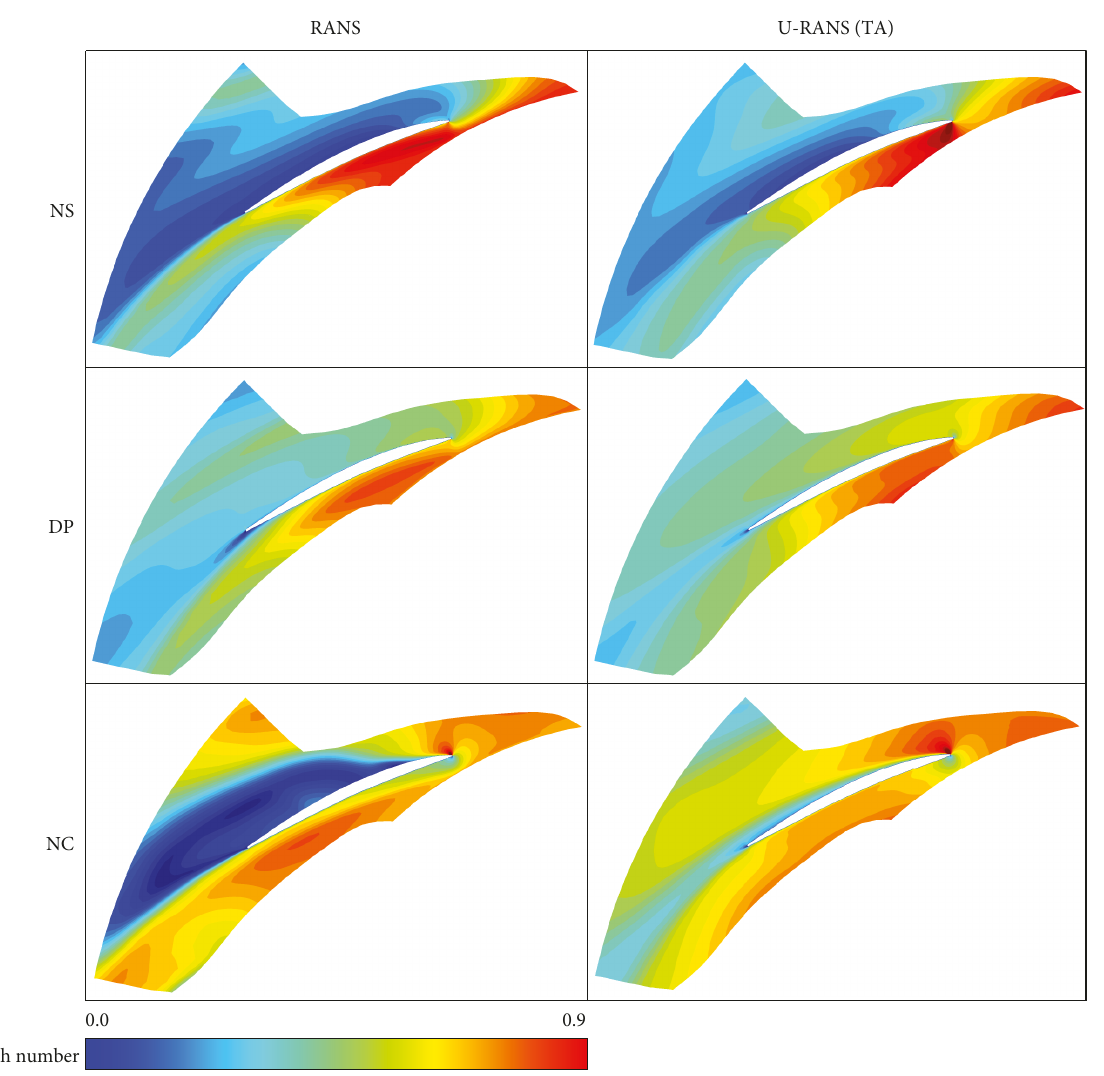
Figure 19: Mach number distribution in the vaned di ff user at the